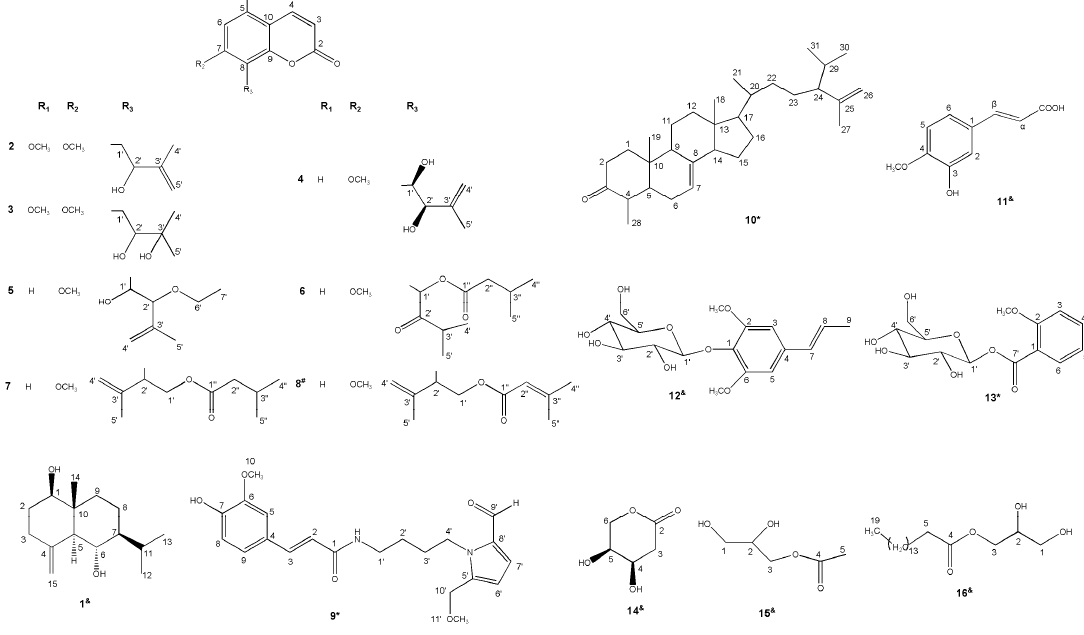
Figure 1. Chemical structures of compounds 1 – 16 ; * represents new compound, # represents new natural product, & represents first isolated compound from Murraya genus.